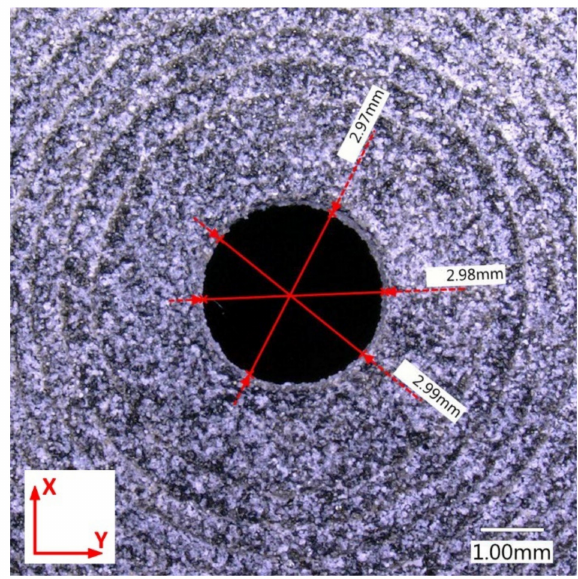
Figure 14. Measured hole diameter of part 4.3.